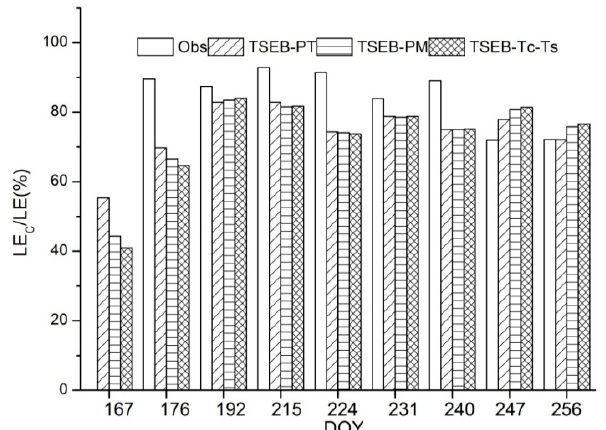
Figure 6. Comparison of LE C / LE (%) between the three TSEB models and ground measurements by stable oxygen and hydrogen isotopes technique at Daman superstation.